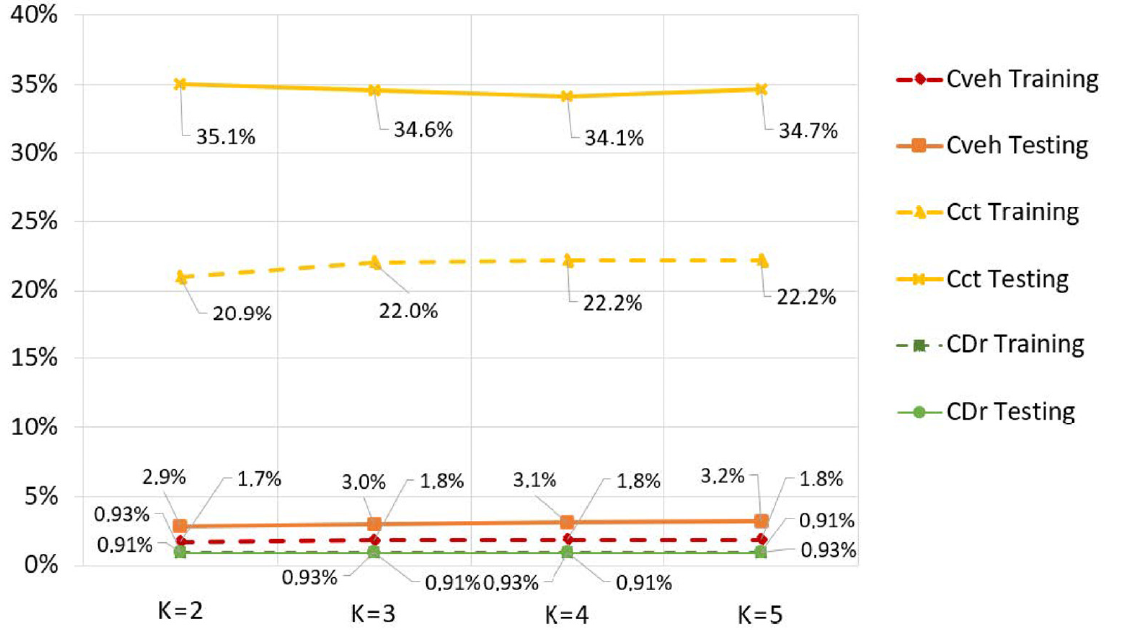
Figure 11. Evolution of the MAE indicator as a function of KNN.